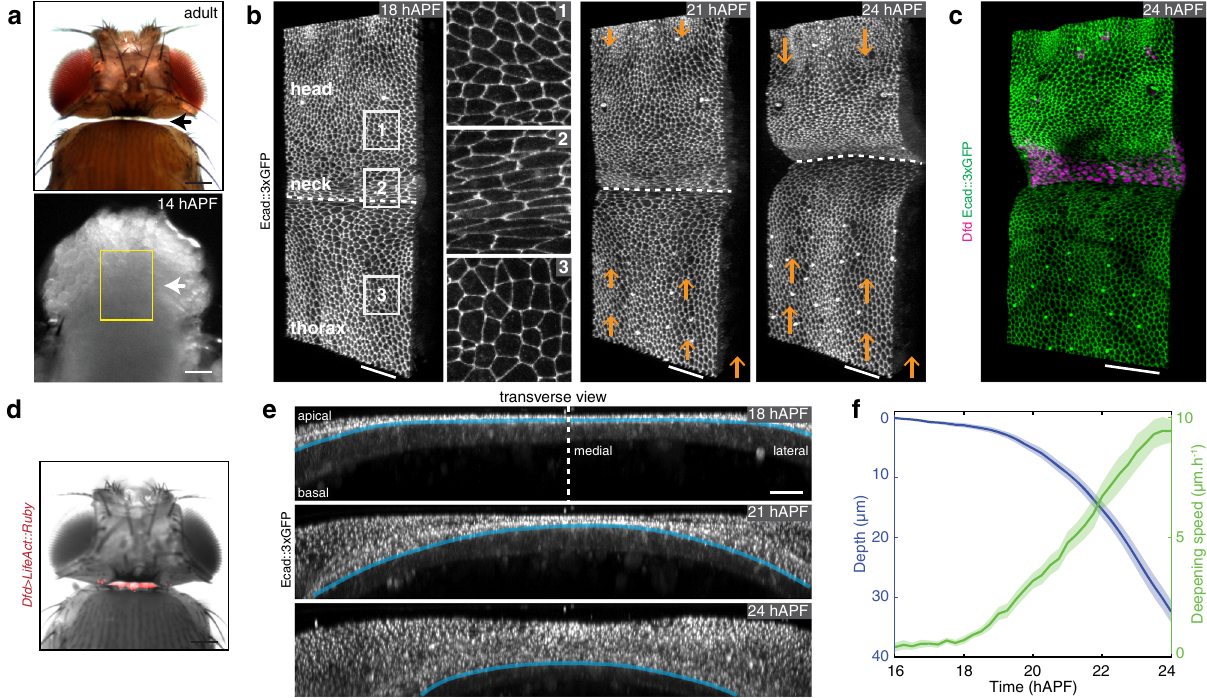
Fig.1| Drosophila neckfoldingduringpupaldevelopment.a Dorsalviewimages ofa Drosophila adult(top)anda14hAPFpupa(bottom).Arrows,thepositionofthe adult neck. Yellow box, region imaged in ( b ). b Time-lapse 3D images of Ecad::3xGFP at 18, 21, and 24 hAPF during neck fold formation. See also Supple- mentary Movie 1. 1 – 3 Close-ups of the head, neck, and thorax cells in the regions indicatedinthe leftimage. Orangearrows indicate the tissue velocity inthe thorax andtheheadfrom18to21hAPFandfrom21to24hAPF(10 µ mh − 1 , orangearrowsin the bottom right). Dashed white line, apical fold front. c 3D image of Ecad::3xGFP and Dfd localizations in the dorsal neck region at 24 hAPF. d Dorsal view of a